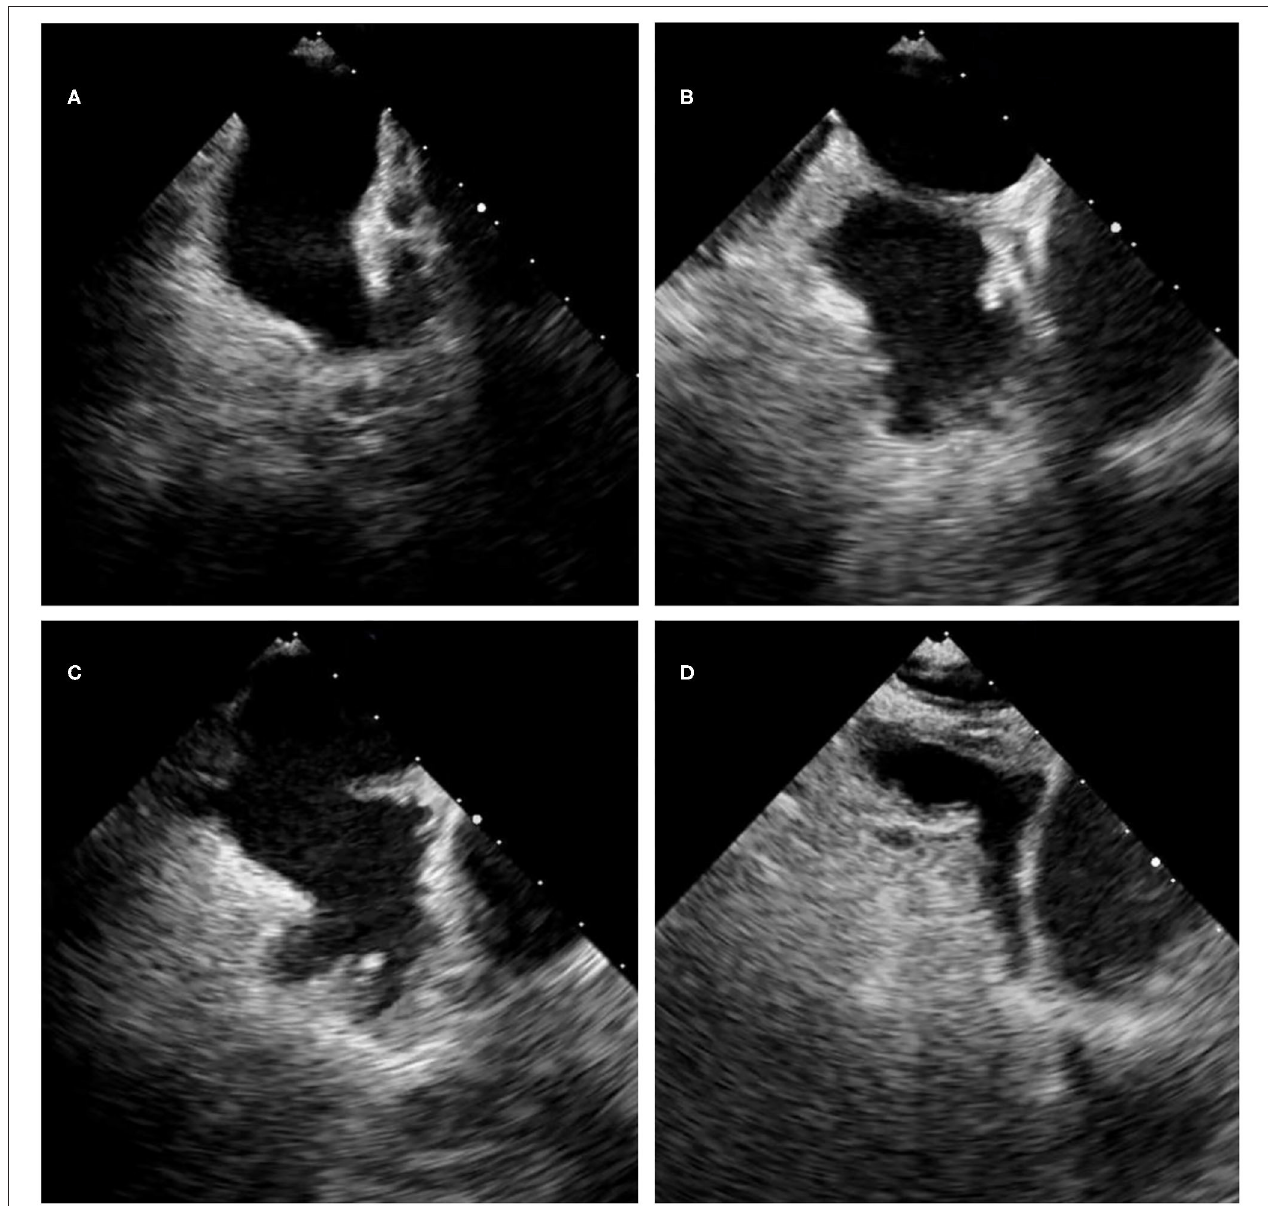
FIGURE 1 | The LAA morphology by 2D transesophageal echocardiography. (A) The chicken-wing morphology. (B) The cauliflower morphology. (C) The cactus morphology. (D) The windsock morphology.